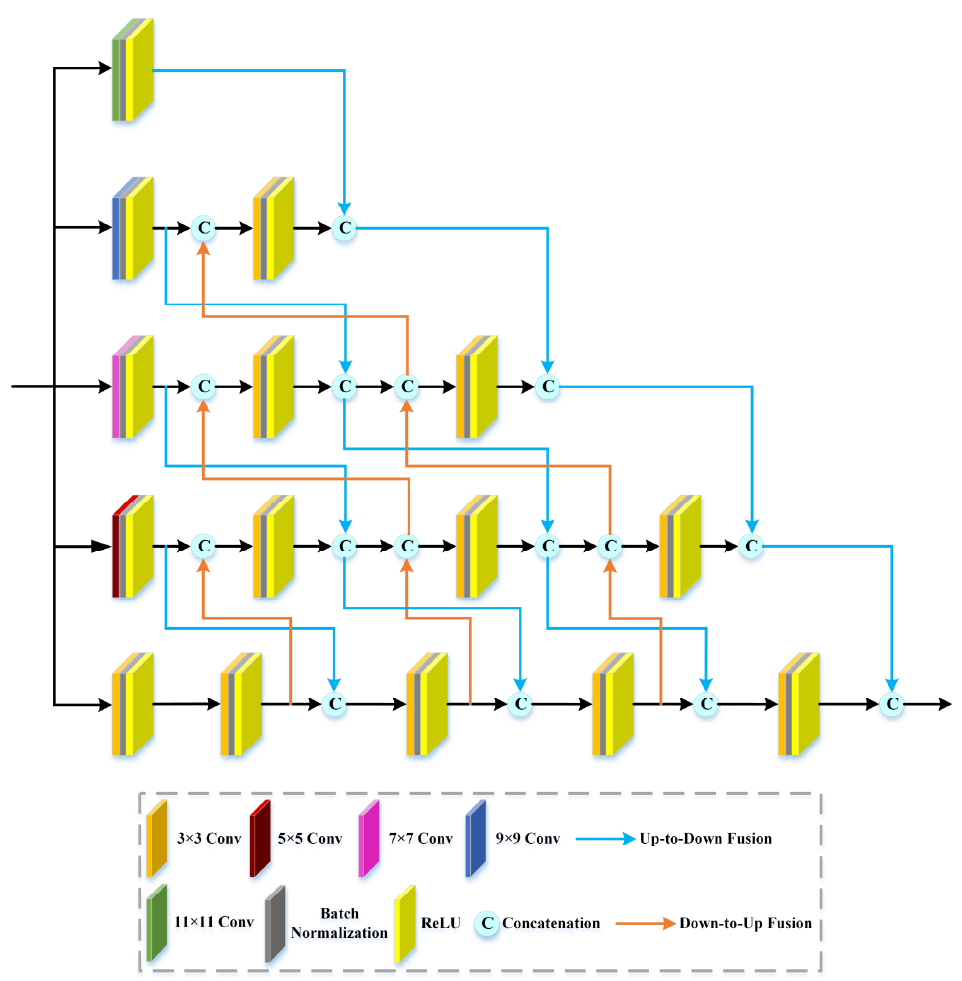
Figure 3. The diagram of multiscale cross feature extraction module (MFEM).